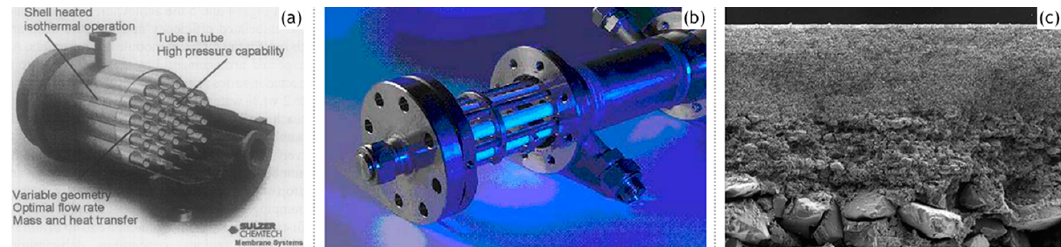
Figure 6. ( a ) Isothermal module concept Pervap ® SMS (silica membrane system) from Sulzer Chemtech, adapted from [63], with permission from Copyright (2004), Elsevier Science B.V. ( b ) Bench-scale seven membrane shell-and-tube design module with ba ffl es and perpendicular feed flow, adapted from [64], with permission from Copyright (2005), Elsevier Ltd. ( c ) SEM cross-section of an amorphous silica membrane (scale 1:500), adapted from [65] with permission from Copyright (2005), Elsevier